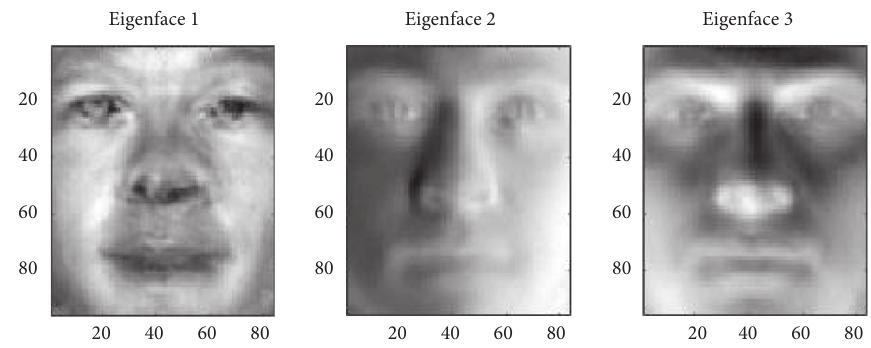
Figure 4: First six eigenfaces of AT&T.